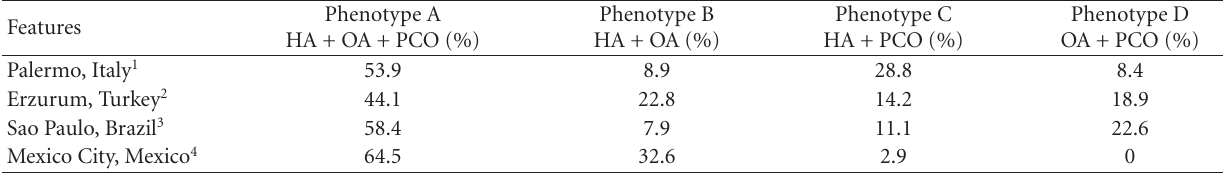
Table 1: Phenotype classification of PCOS patients in di ff erent populations.